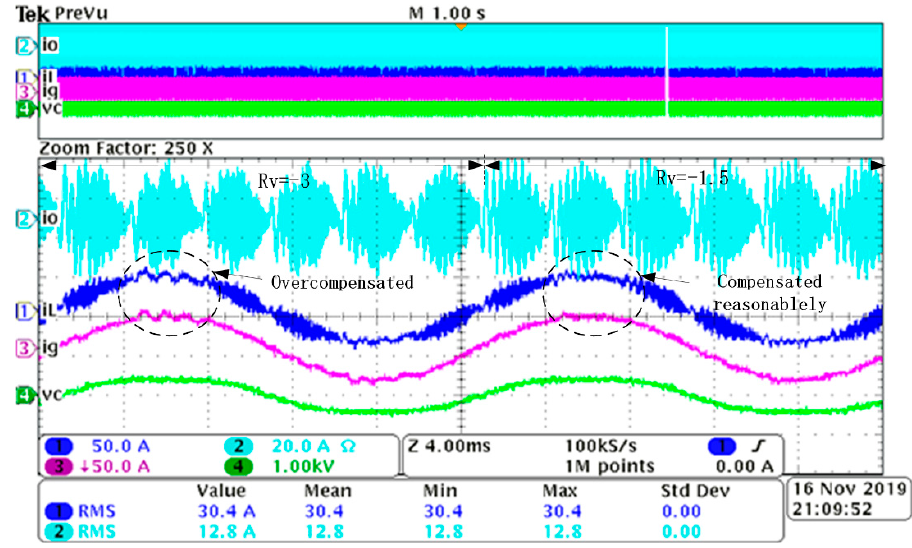
Figure 16. Waveform of i o , i L , i g , and v c with R v varied from -3 to -1.5.